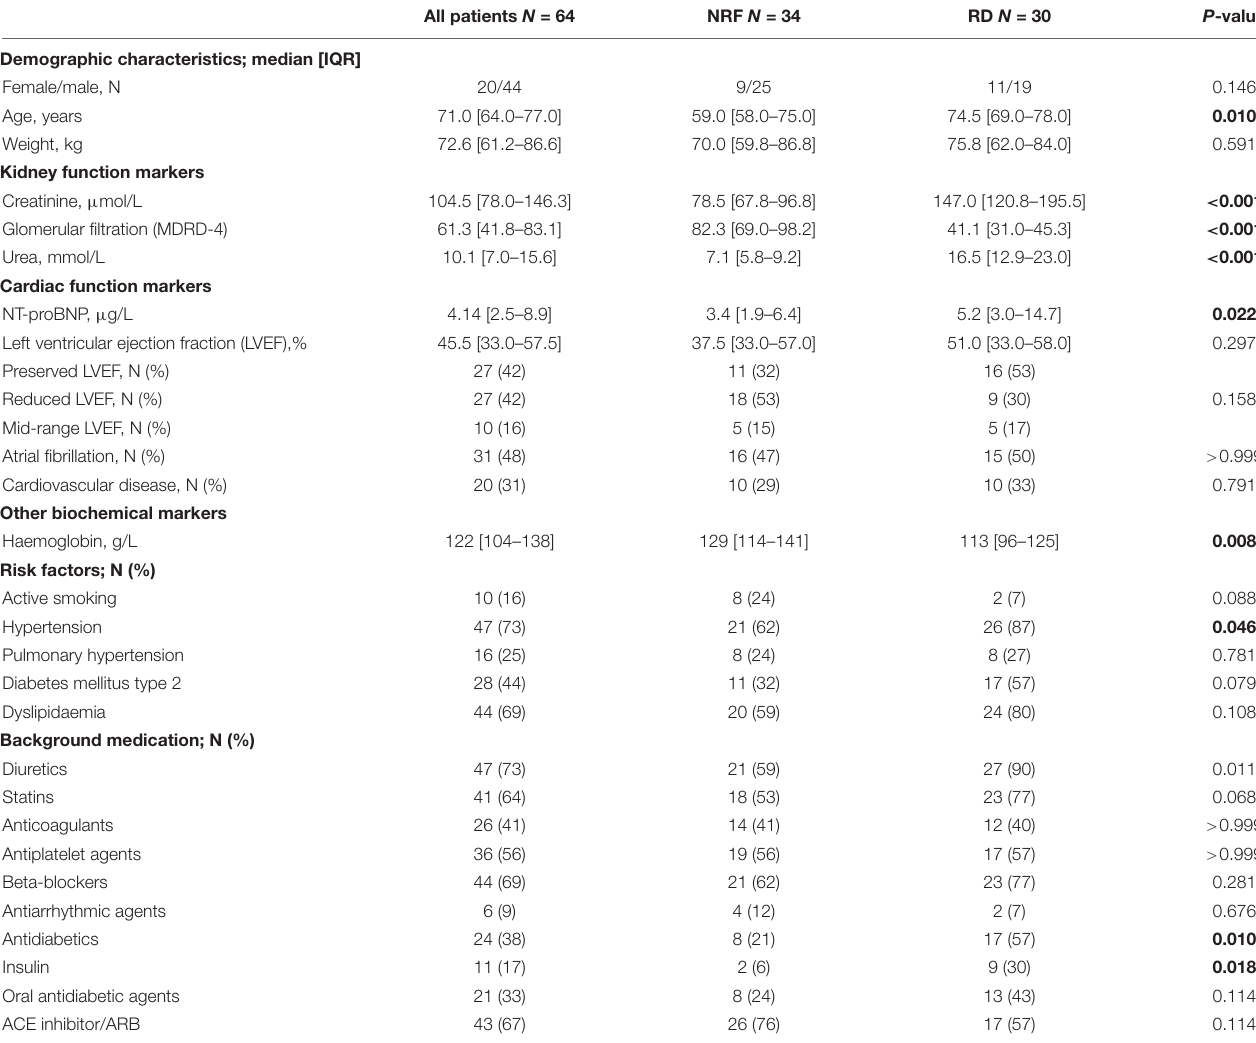
TABLE 1 | Patient baseline